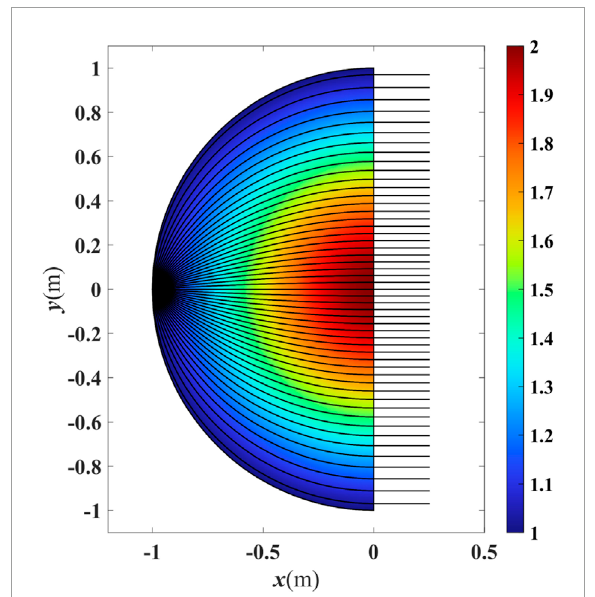
FIGURE 1 Ray trajectories and refractive index of an HMFEL. Parameters n 0 = 1 and R = 1 are considered in Eq. 1 .